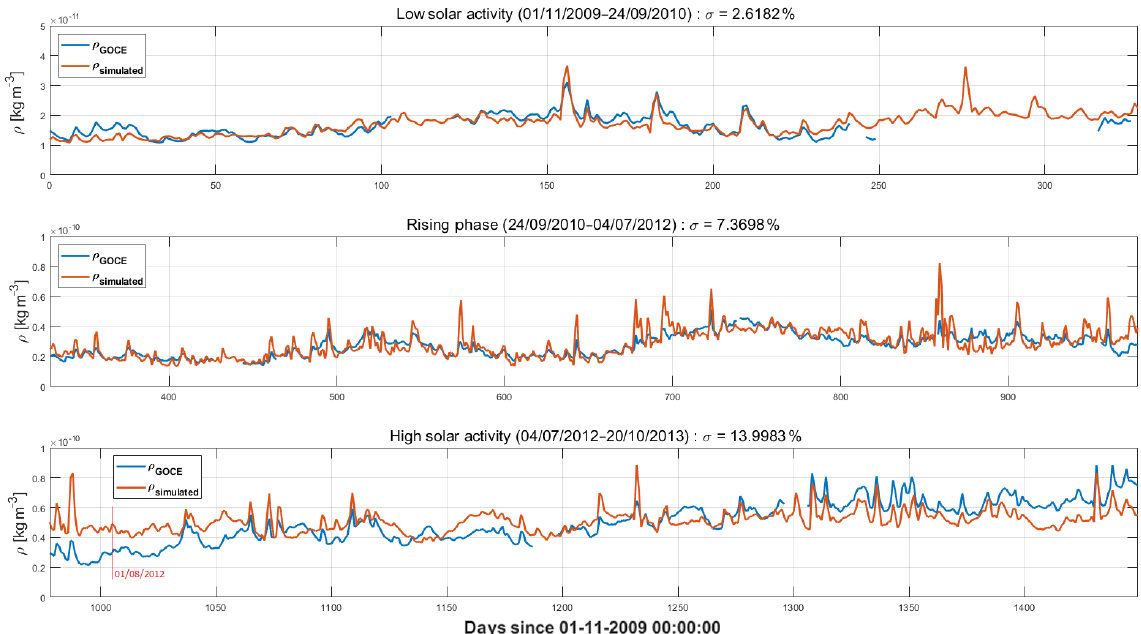
Figure 11. Optimal synthesized thermospheric density from Ap, Mg II and F10.7. Three different EMD sets for the extent of the whole mission, each covering one of the three selected dynamical activity regimes for solar cycle 24, low, rising and high. The trend in density apparent in the phase of high solar activity is due to orbit lowering and is therefore not shown in the reconstructed signal.